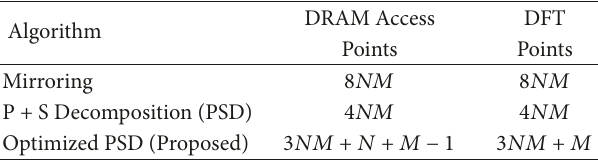
Table 1: Comparing mirroring, PSD, and OPSD.